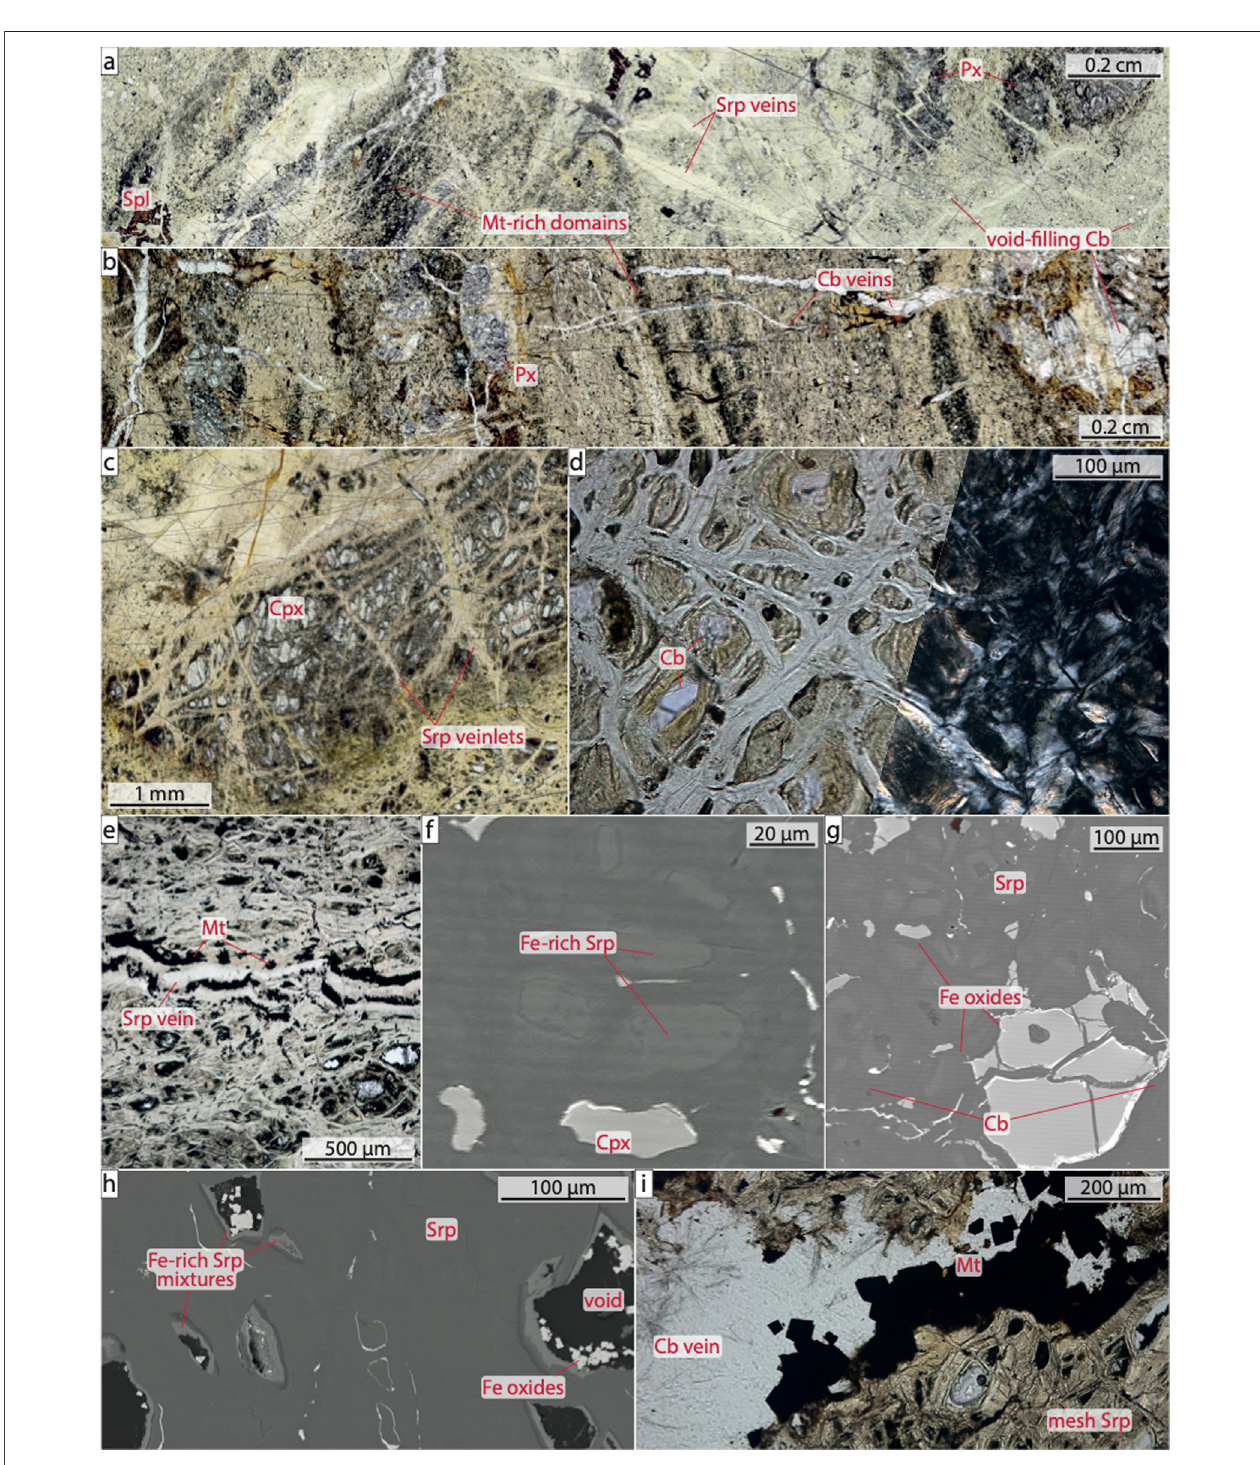
FIGURE 2 | Petrographic and textural features of the studied samples (A) Thin section scan showing a typical sample with domains of magnetite-poor serpentine mesh textures and darker domains enriched in magnetite. Pyroxene is partly and spinel is mostly unaltered. Light-colored serpentine veins crosscut previous textures. Carbonate fi llsvoids,manyofwhichmayhavebeenformermeshcenters.Sample27R-4,75 – 79 cm,planepolarizedlight(PPL) (B) Thinsectionscanshowingadomain rich in mostly unaltered pyroxene. Magnetite appears concentrated in elongated domains (dark areas). Carbonate veins crosscut the sample. Sample 25R-3, 10 – 13 cm, PPL (C) Photomicrograph depicting mostly unaltered clinopyroxene with some serpentine present along intragranular fractures. Sample 25R-5, 119 – 122 cm, PPL (D) Photomicrograph showing typical serpentinite mesh texture. Carbonate occurs in some mesh centers. Sample 27R-2, 126 – 130 cm, PPL